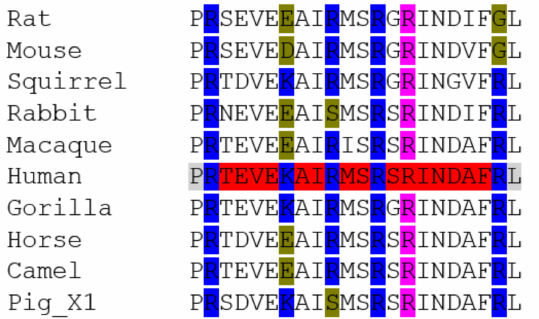
Figure 2. The alignment of the cleavage site of ACE2 (region 697–716). Human cleavage site is highlighted in red. Significant arginine and lysine residues are in blue with differences in animal species shown in brown. Grey highlights indicate human